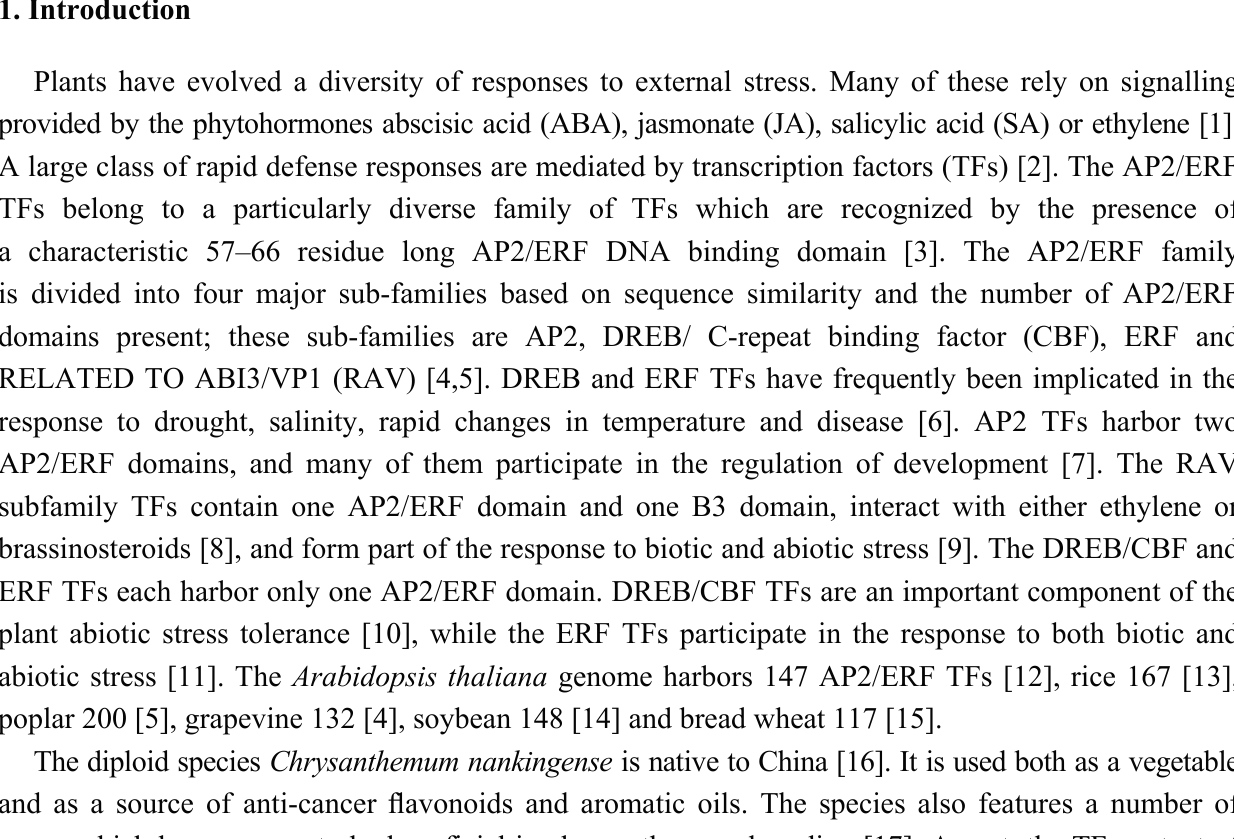
(Figure 1a). Analysis using Smart online software (available online: http://smart.embl-heidelberg.de/) showed that the conserved residues in the CnERF1 AP2/ERF were A14 and D19. The corresponding positions in CnDREB1-1 , 1-2 and 1-3 were occupied by, respectively valine and leucine, whereas in CnDREB3-1 and 3-2 , the 19th residue was glutamic acid. The 14th and 19th residues are both located on the β -sheet of the AP2/ERF